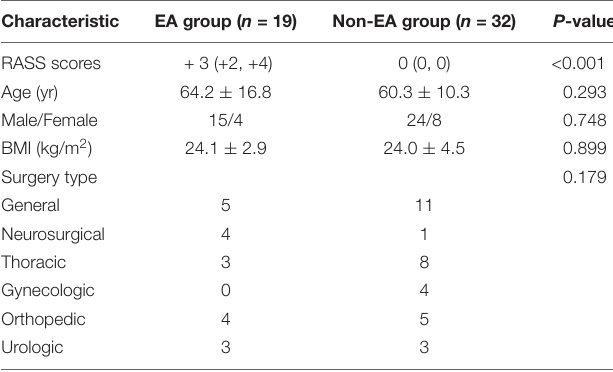
TABLE 2 | Patients characteristics and surgery types of the EA and Non-EA groups.